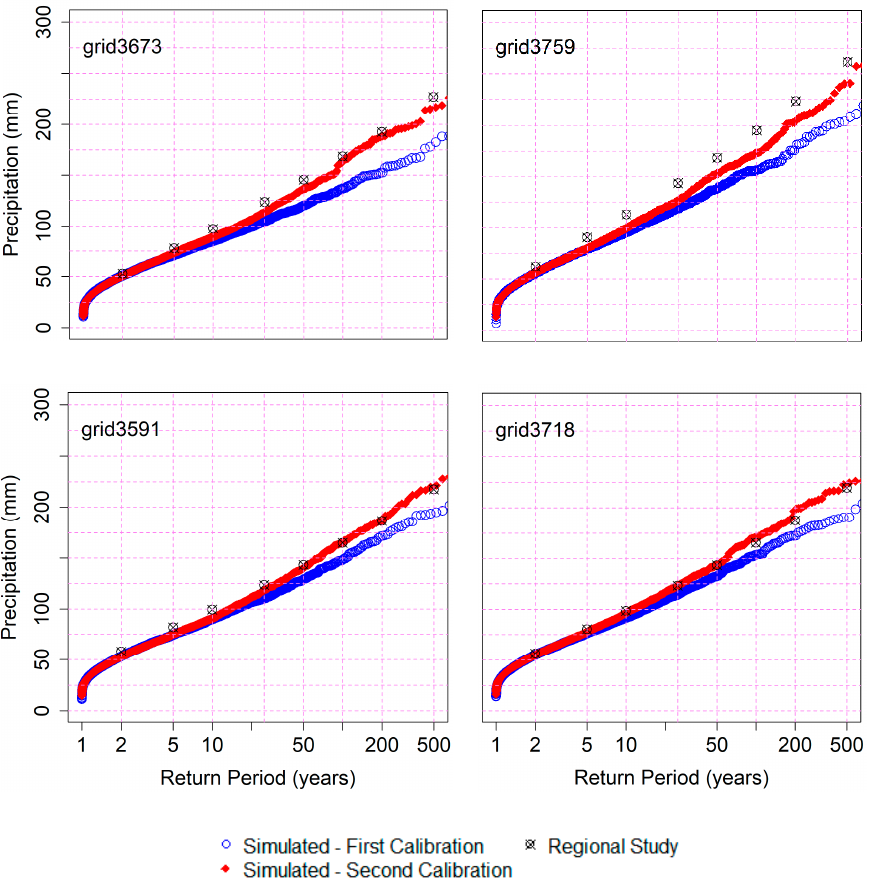
Figure 6. Results of WG calibration in four representative grid points.